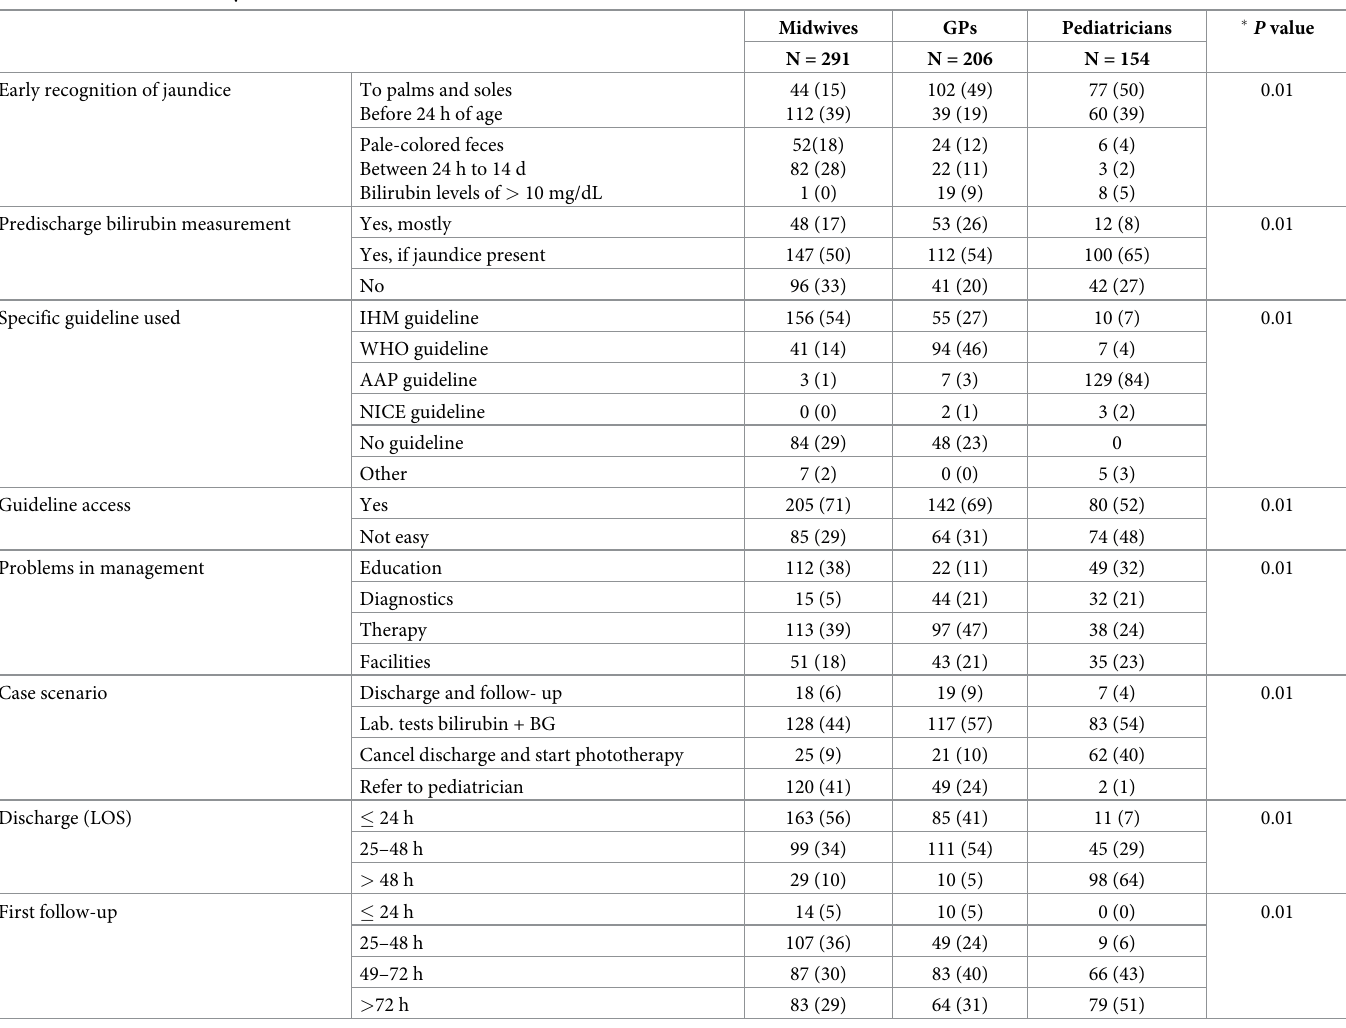
Table 2. Results of the